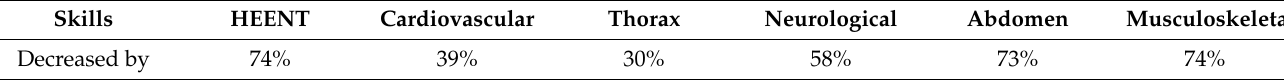
Table 2. Physical Assessment Skills Percent